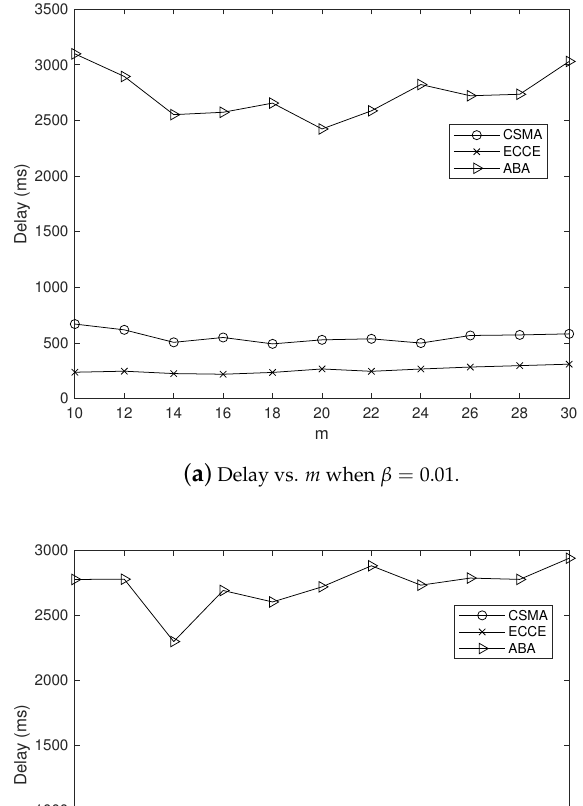
( b ) Delay vs. m when β = 0.02.